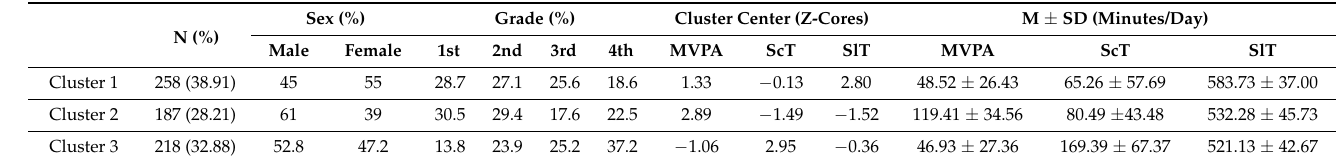
Table 5. Descriptive statistics for the three clusters.